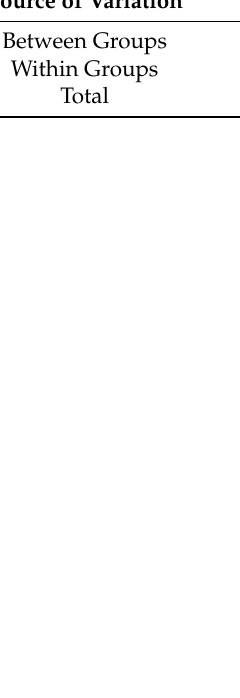
Table 10. Single factor analysis of variance (ANOVA) of trace element concentrations in road dust. Analysis of Variance in Road Dust